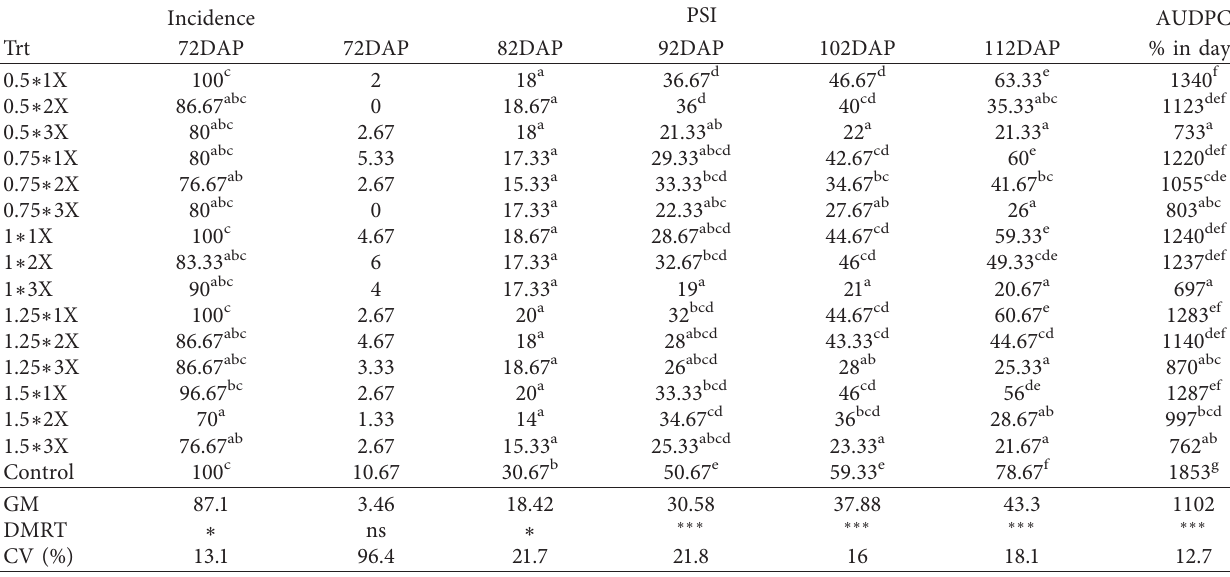
Table 3: The mean of garlic rust disease incidence, PSI at d/ t days, and AUDPC data at Segno in 2019 cropping season. Incidence PSI AUDPC Trt 72DAP